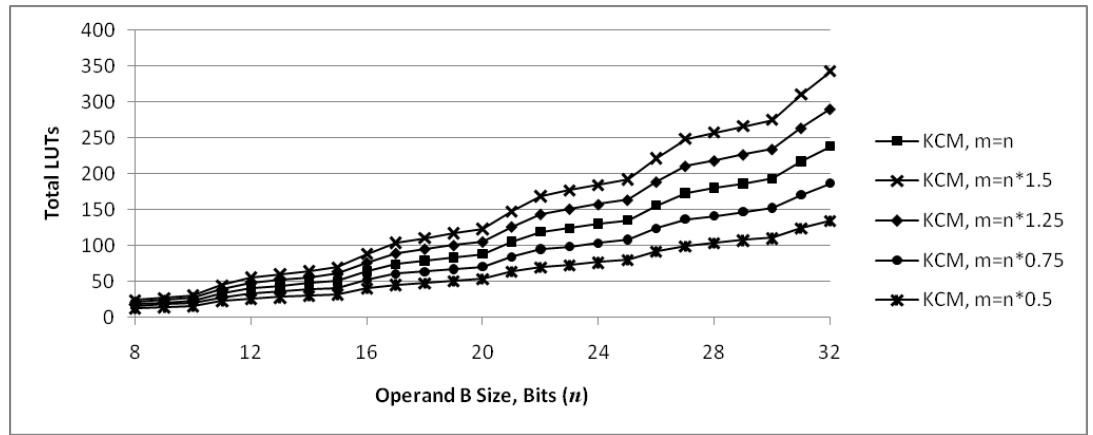
Figure 7. Number of 6-input lookup tables (LUT6s) required for KCMs as m and n are varied. For a given value of n , the change in the number or LUTs is roughly proportianal to ∆ m .